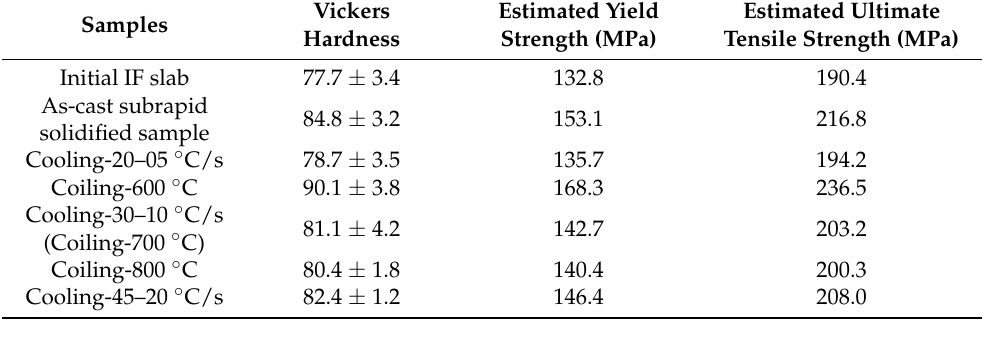
Table 2. Vickers hardness and estimated strength.